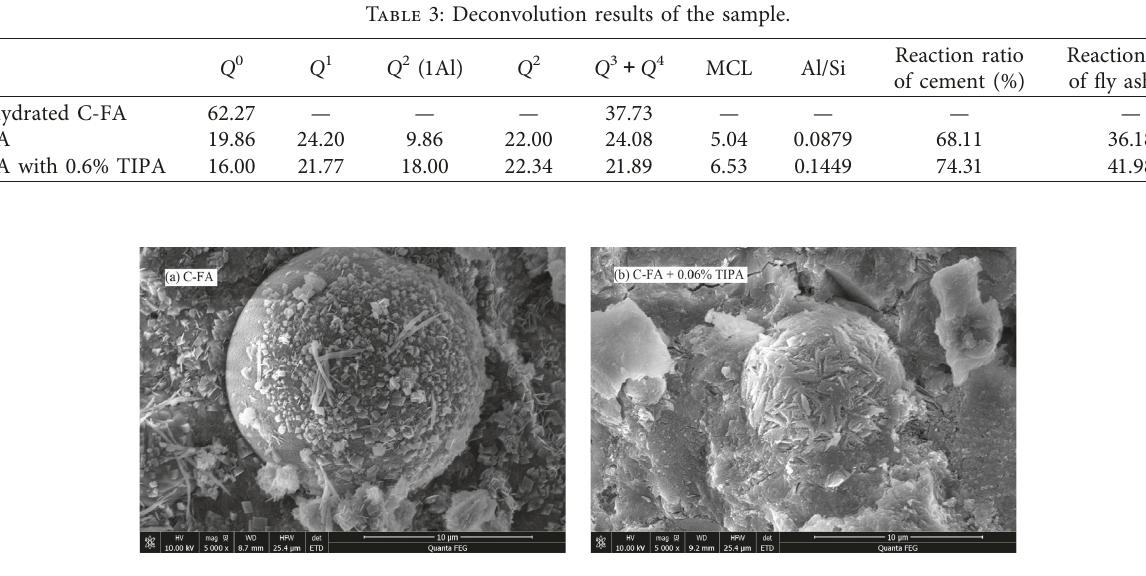
Figure 8: SEM images of the paste hydrated for 60d.